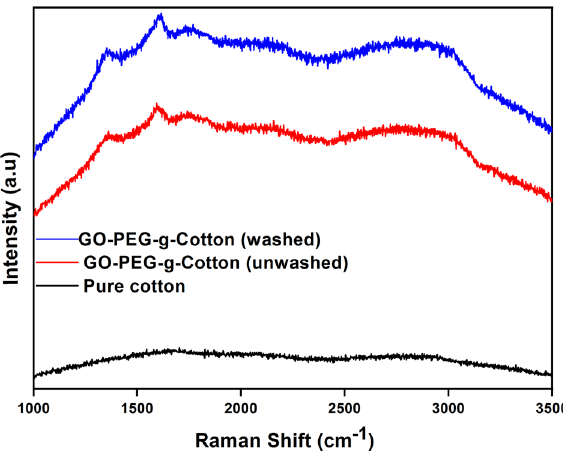
Figure 3. Raman spectra of pure cotton and GO-PEG-g-Cotton.